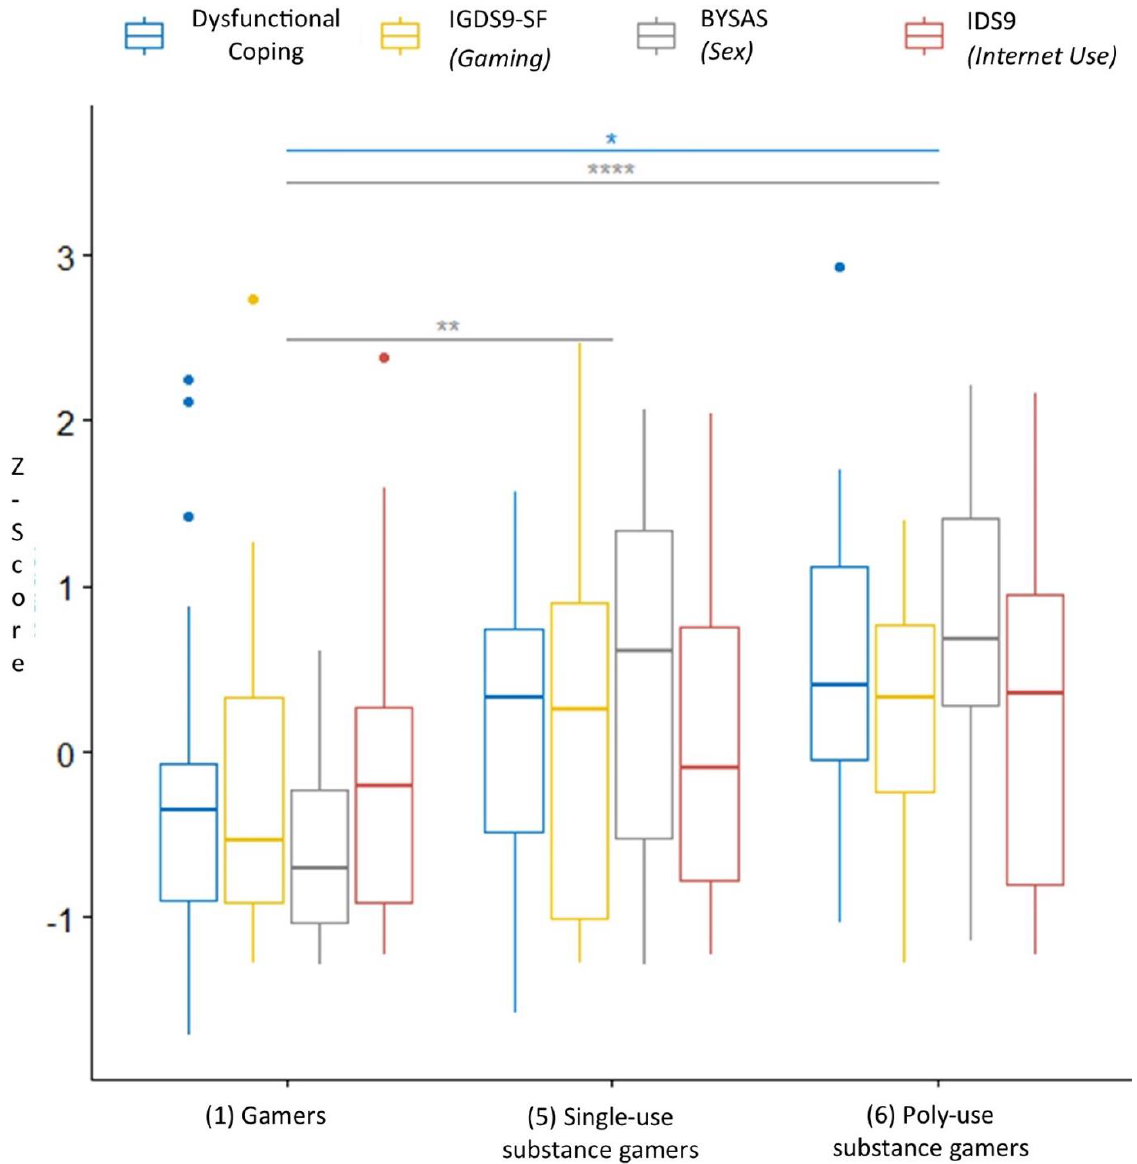
Figure 2. Pairwise Comparison . Games Howell pairwise comparison of z-scores with Tukey correc- tion of group 1, 5, and 6. * p = 0.01; ** p = 0.003; **** p < 0.00014.